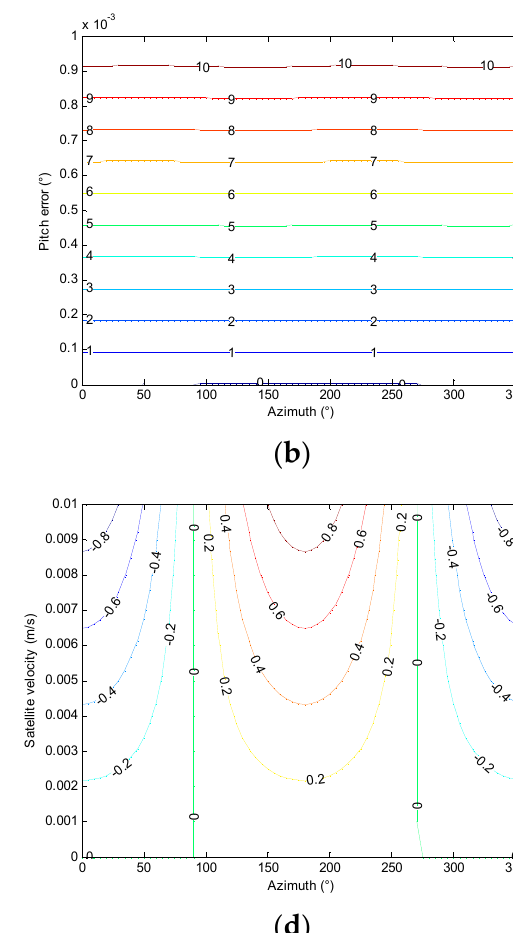
( c ) roll; ( d ) satellite velocity.